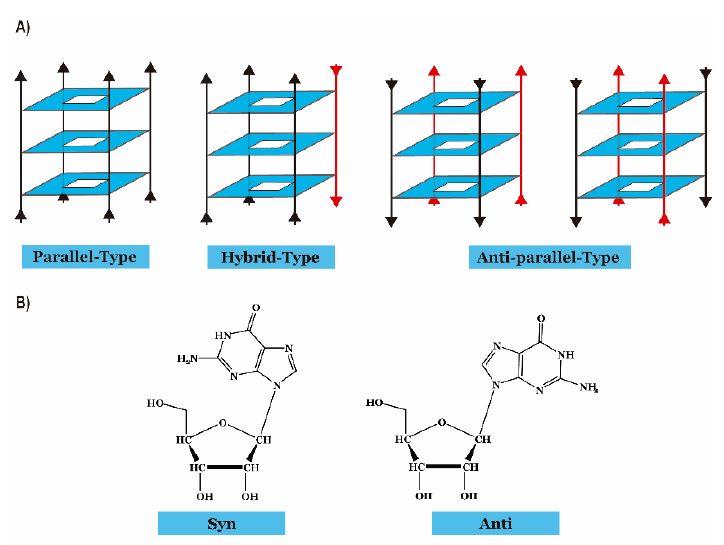
Figure 2. ( A ) Schematic representation of different G4 topologies (parallel, hybrid and anti-parallel). ( B ) Conformations of G4s according to strands polarity when polarity differences are associated with an angle between the G-bases and the pentose, namely to 2’ hydroxyl group.